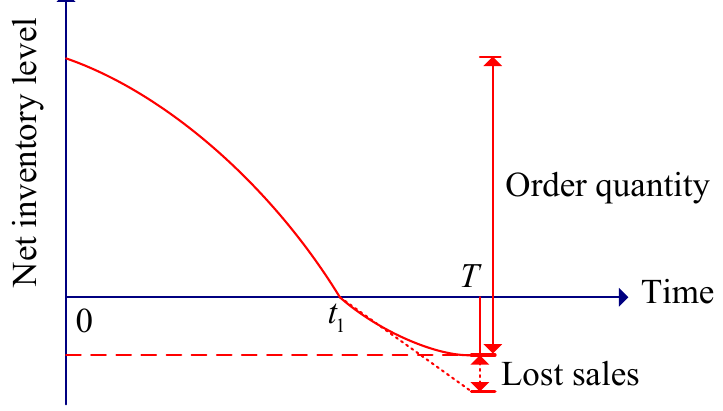
Figure 1. Graphical representation of the inventory level over inventory cycle T